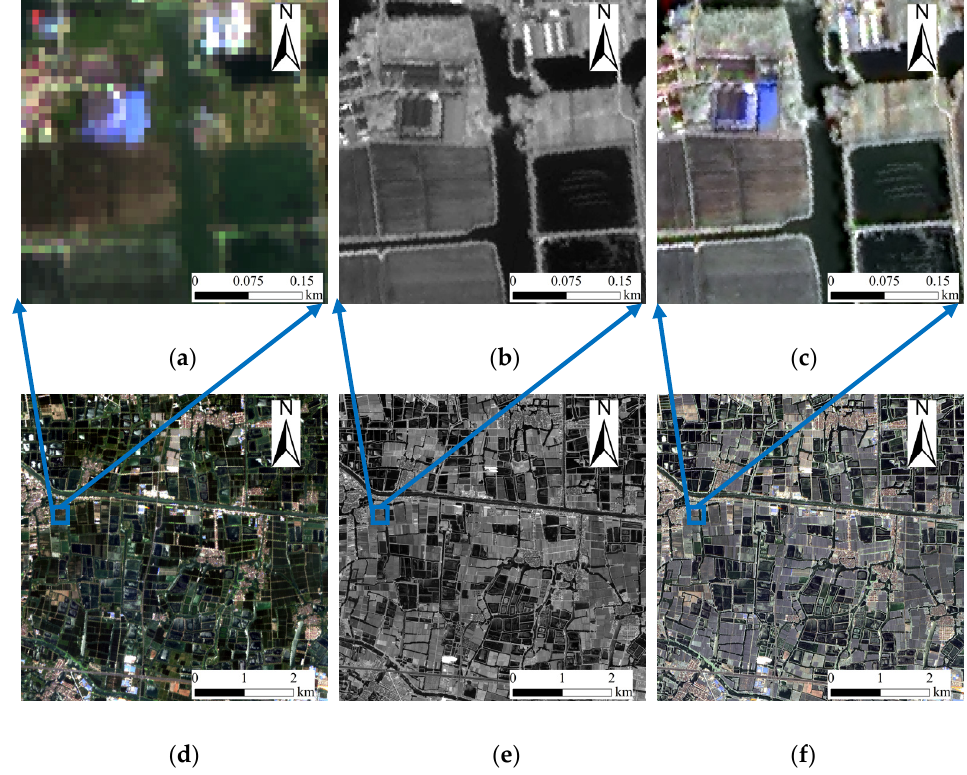
Figure 2. Images on the bottom show the GF-1 multi-spectral ( d ), panchromatic ( e ) and pan-sharpened ( f ) images. Images on the top show their corresponding enlarged details ( a , b , c ).